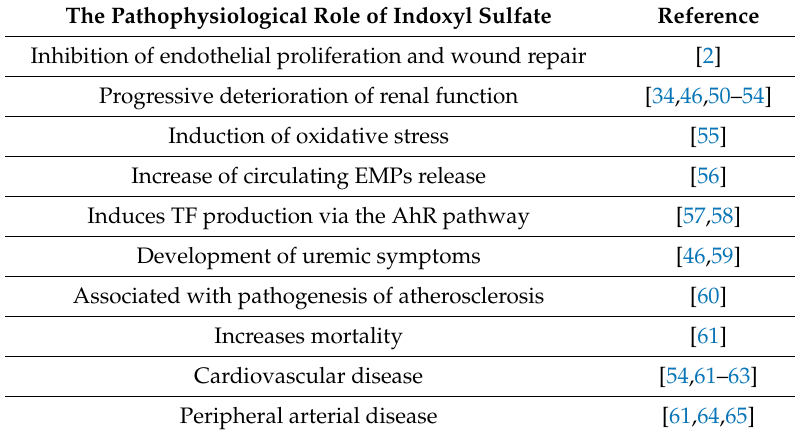
Table 2. The pathophysiological roles of Indoxyl